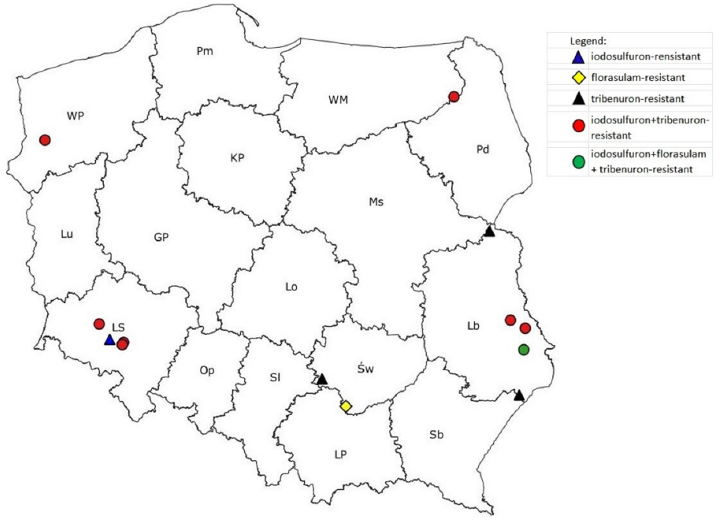
Figure 1. Locations in Poland where herbicide-resistant populations of P. rhoeas L. were found.